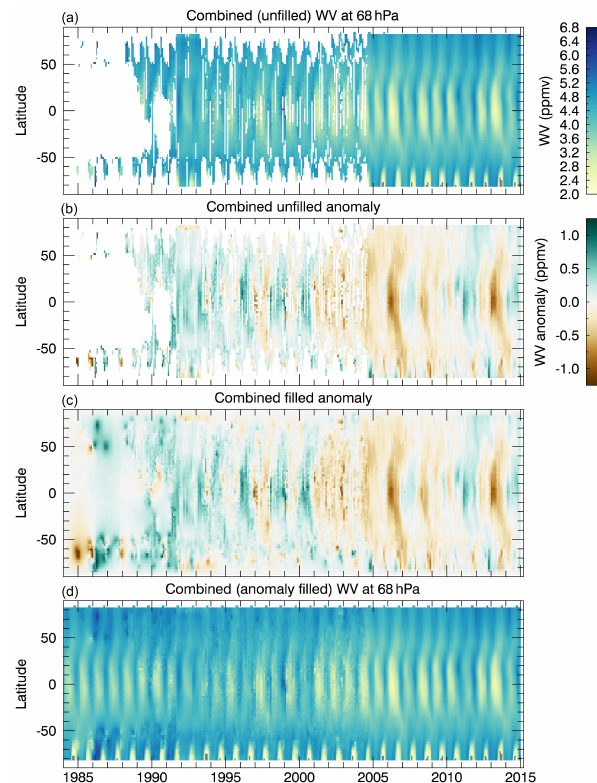
Figure 11. (a) Combined (unfilled) latitude vs. time cross section of WV at 68hPa. (b) The anomaly of (a) , defined as (a) minus the seasonal cycle at each latitude. (c) A filled version of (b) , using ra- dial basis function interpolation. (d) The combined (anomaly filled) product, which is constructed by adding the (latitude-dependent) seasonal cycle to the filled anomaly (c)